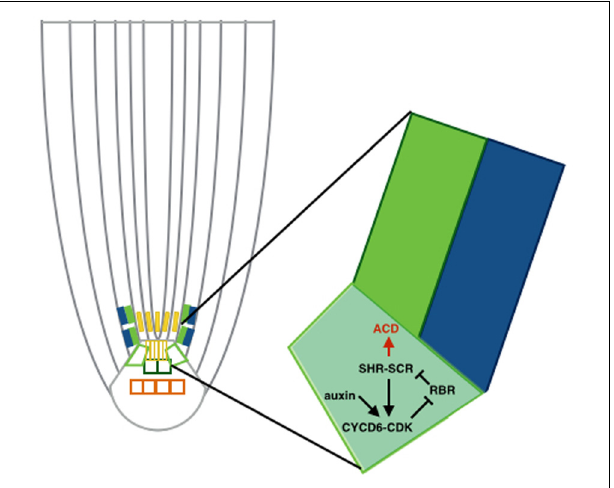
FIGURE 2 |Asymmetric cell divisions (ACD) regulated by auxin maximum. Schematic of a cortex-endodermis initial cell, where auxin positively regulates transcription of CYCD6;1 and consequently triggers the ACD.The auxin maximum in the QC restricts the ACD to the